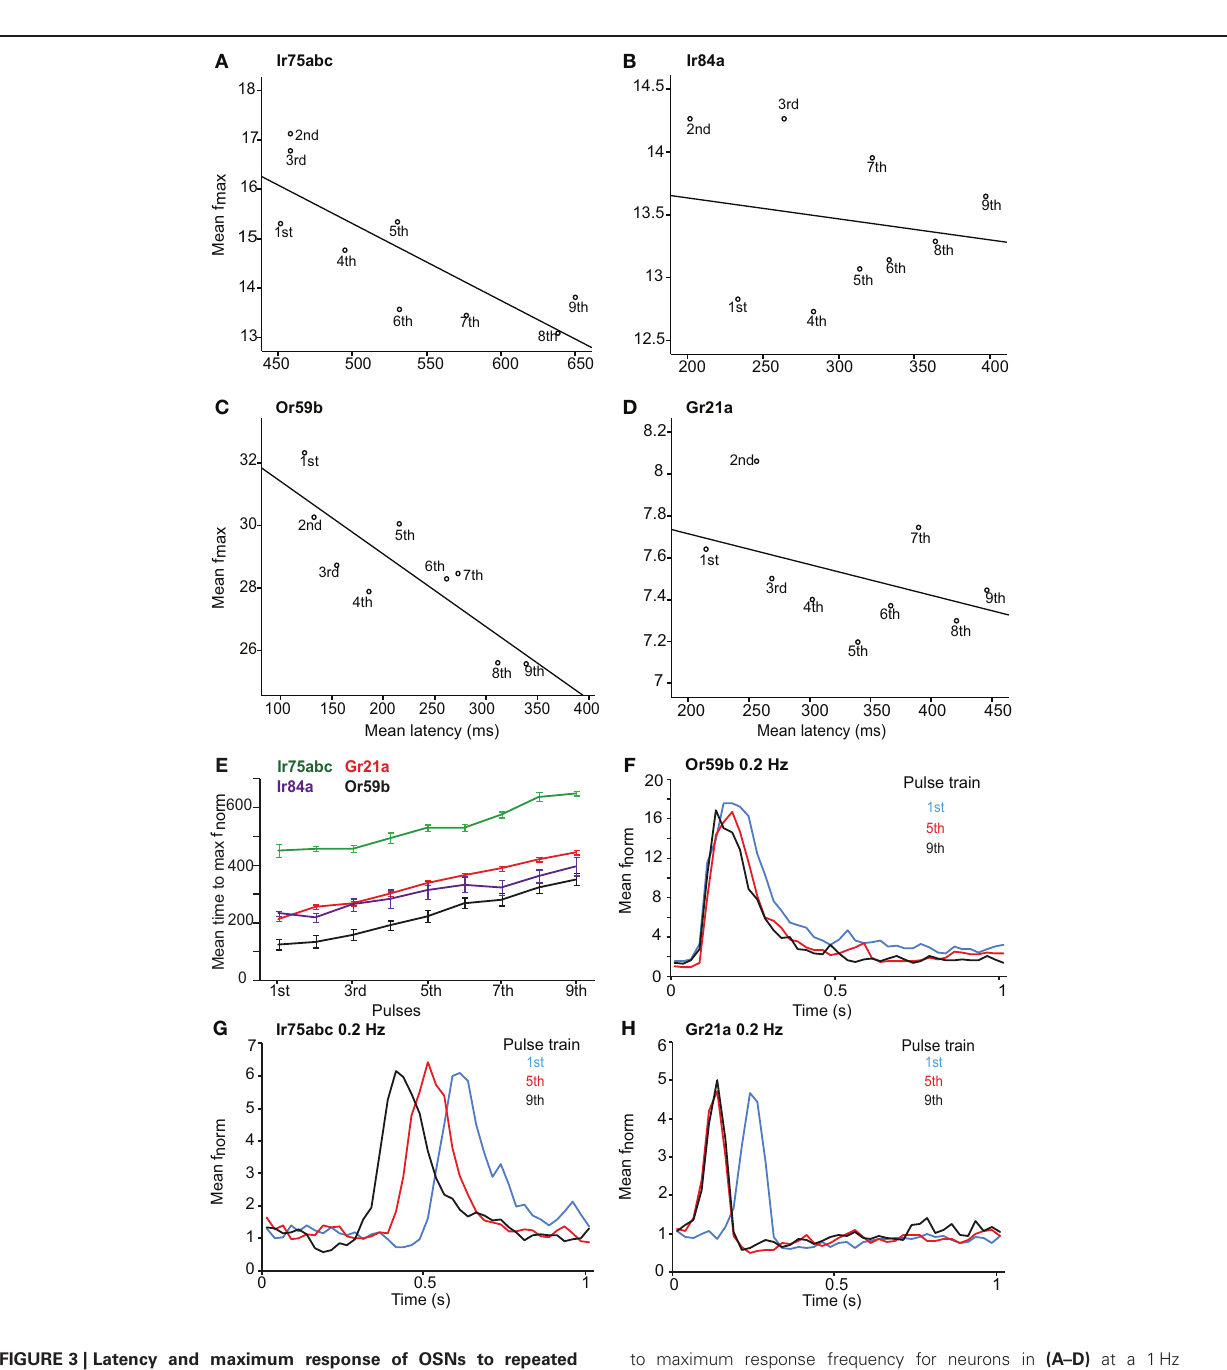
to maximum response frequency for neurons in (A–D) at a 1Hz repeated stimulation. (F) The response onset recovery of Or59b-expressing OSNs when stimulated at 0.2Hz, n = 10 (G) as in (F) for Ir75abc-expressing OSNs, n = 7 and (H) as in Gr21a-expressing OSNs, n =